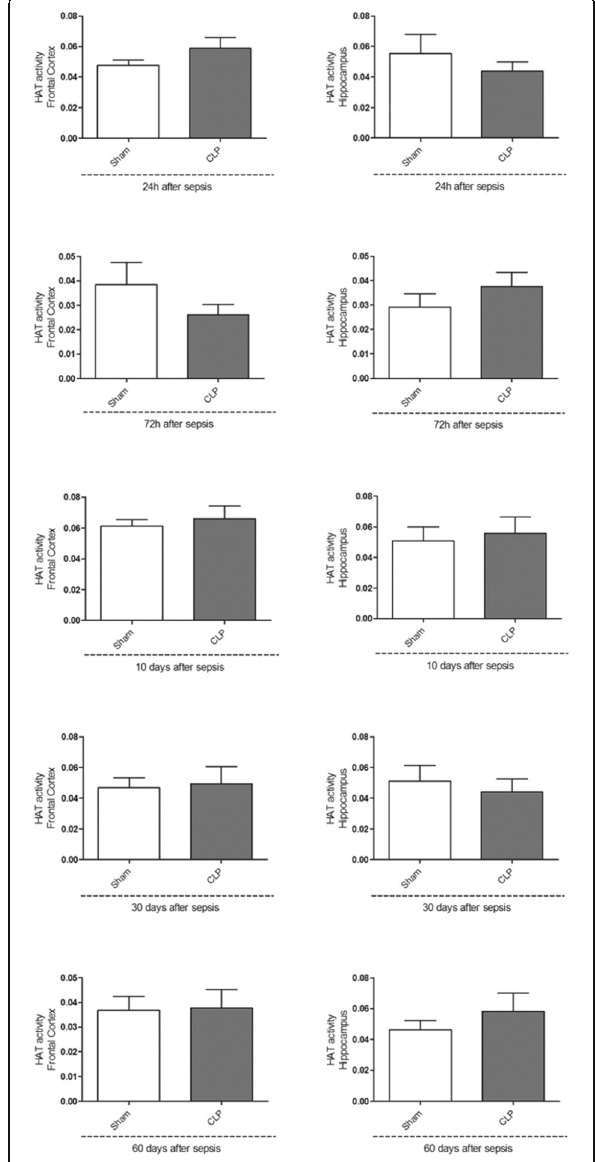
Fig. 1 (abstract P2). See text for